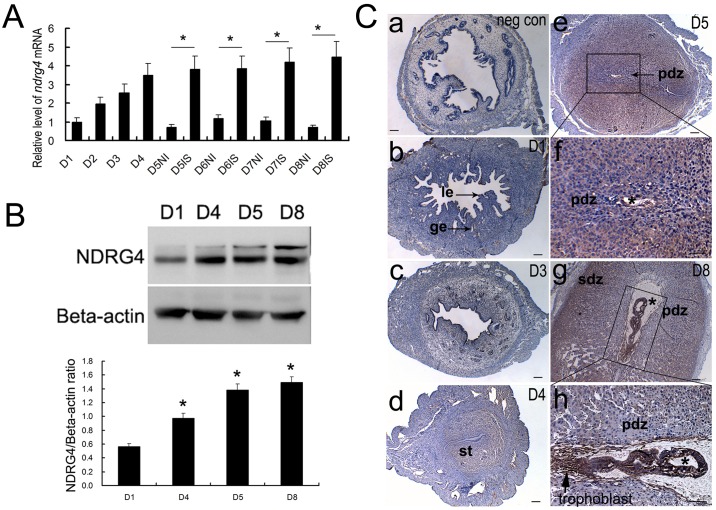
Uterine NDRG4 expression during early pregnancy in mice.(A) Quantitative PCR analysis of NDRG4 mRNA expression in the uterus during early pregnancy (n = 3, *P < 0.05). (B) Western blot and densitometric analyses of uterine NDRG4 protein levels during early pregnancy (n = 3). All experiments were repeated three times. The data are shown as the mean ± SEM. *P < 0.05. (C) Immunohistochemical analysis of uterine NDRG4 protein expression on days 1, 3, 4, 5, and 8 of pregnancy. IS, implantation sites; NI, non-implantation sites. *, indicates the location of the embryo. le, luminal epithelium; ge, glandular epithelium; st, stroma; pdz, primary decidual zone; sdz, secondary decidual zone; D, day of pregnancy; gc, giant cell; Scale bar represents 100 μm.